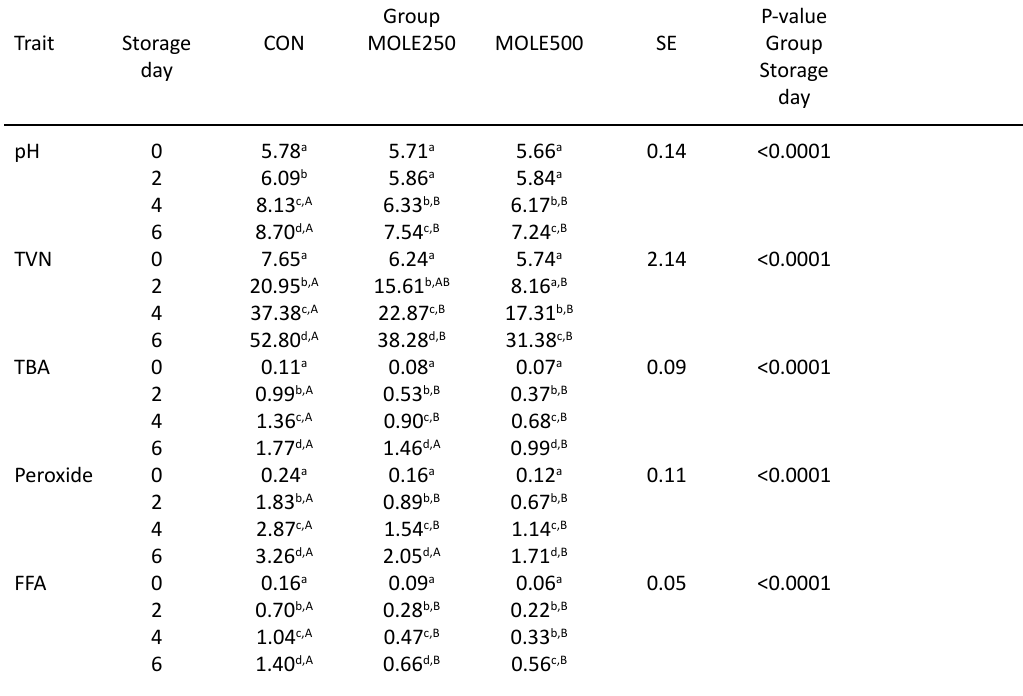
Table 4. Effect of Moringa oleifera leaf extract (MOLE) on objective meat quality traits of breast muscle Group P-value Trait Storage CON MOLE250 MOLE500 SE Group day Storage day pH 0